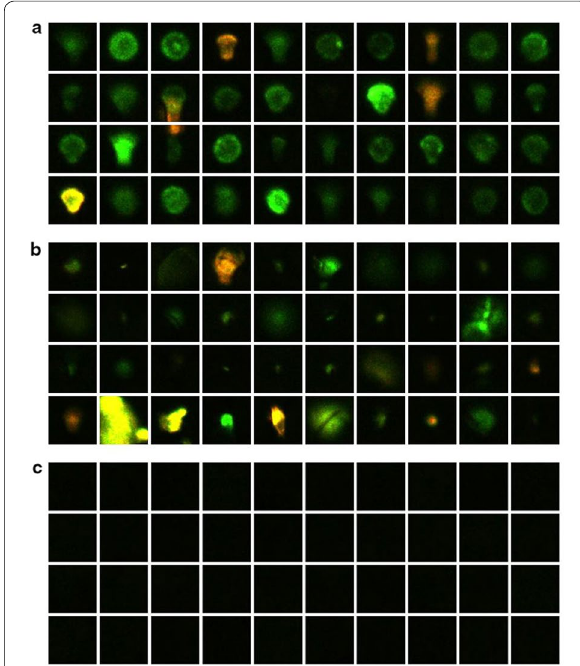
Fig. 3 Example images from the dataset. a Cell images centered and scaled. b Hard negative images, that is manually eliminated. c Background